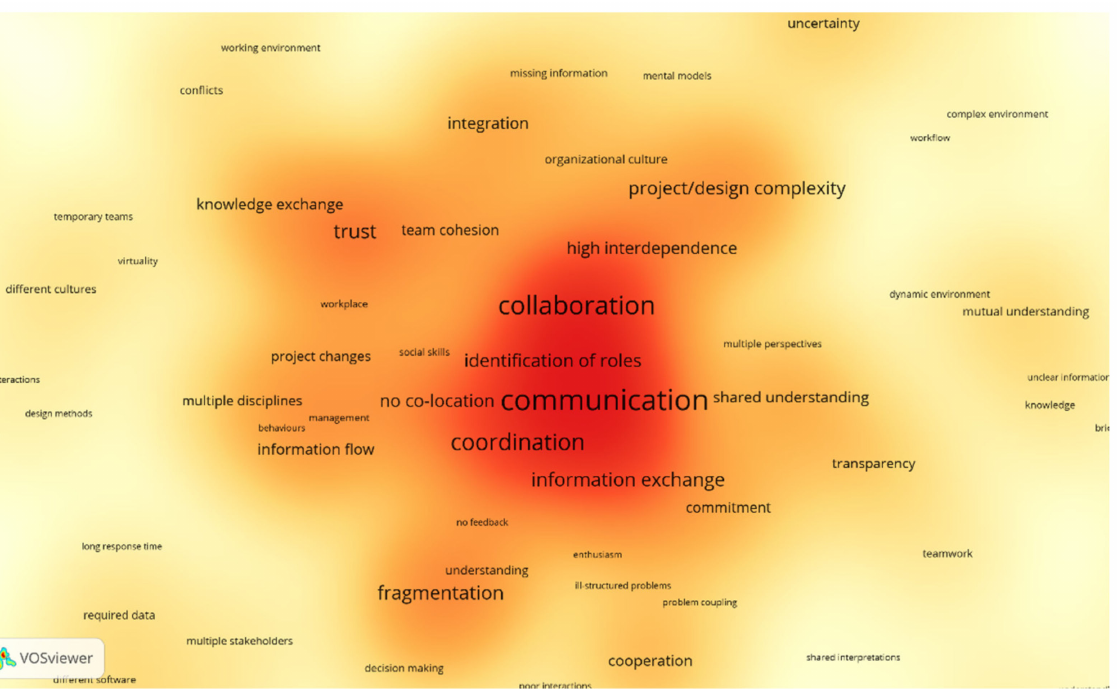
Figure 7. The density of occurrence of the main